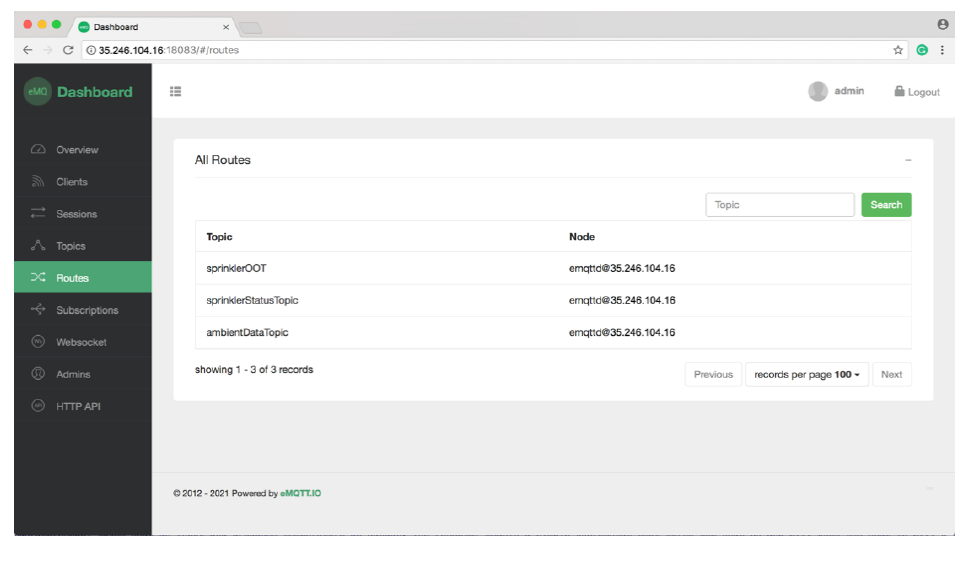
Figure 21. Message Broker.